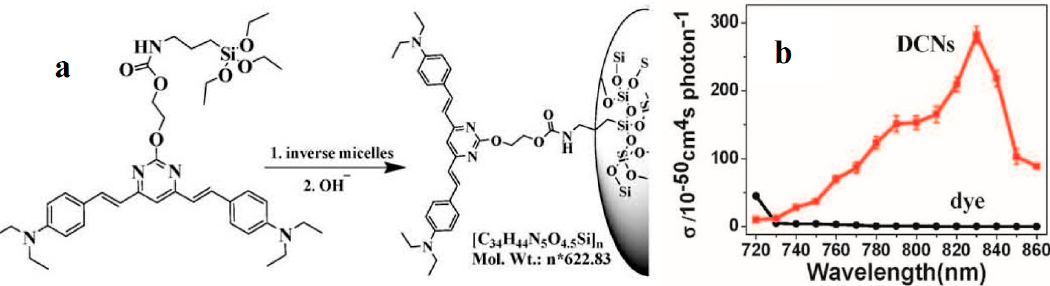
Figure 9. ( a ) Schematic representation of the preparation progress of dye-concentrated nanoparticles (DCNs) ( 52 ); ( b ) 2PA cross section of dye and DCNs in DMF versus excitation wavelengths from 720 nm to 860 nm in DMF.